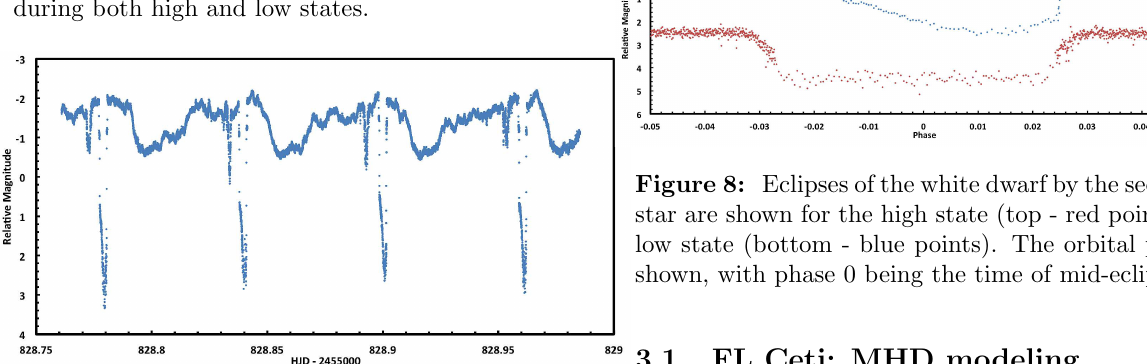
Broad-band (BVR) photometry obtained during a high accretion state of FL Ceti. Outside of eclipse the light curve is dominated by cyclotron emis- sion. During the eclipse the back side of the secondary and the disappearance of the accretion stream provide the only contribution to the optical light.